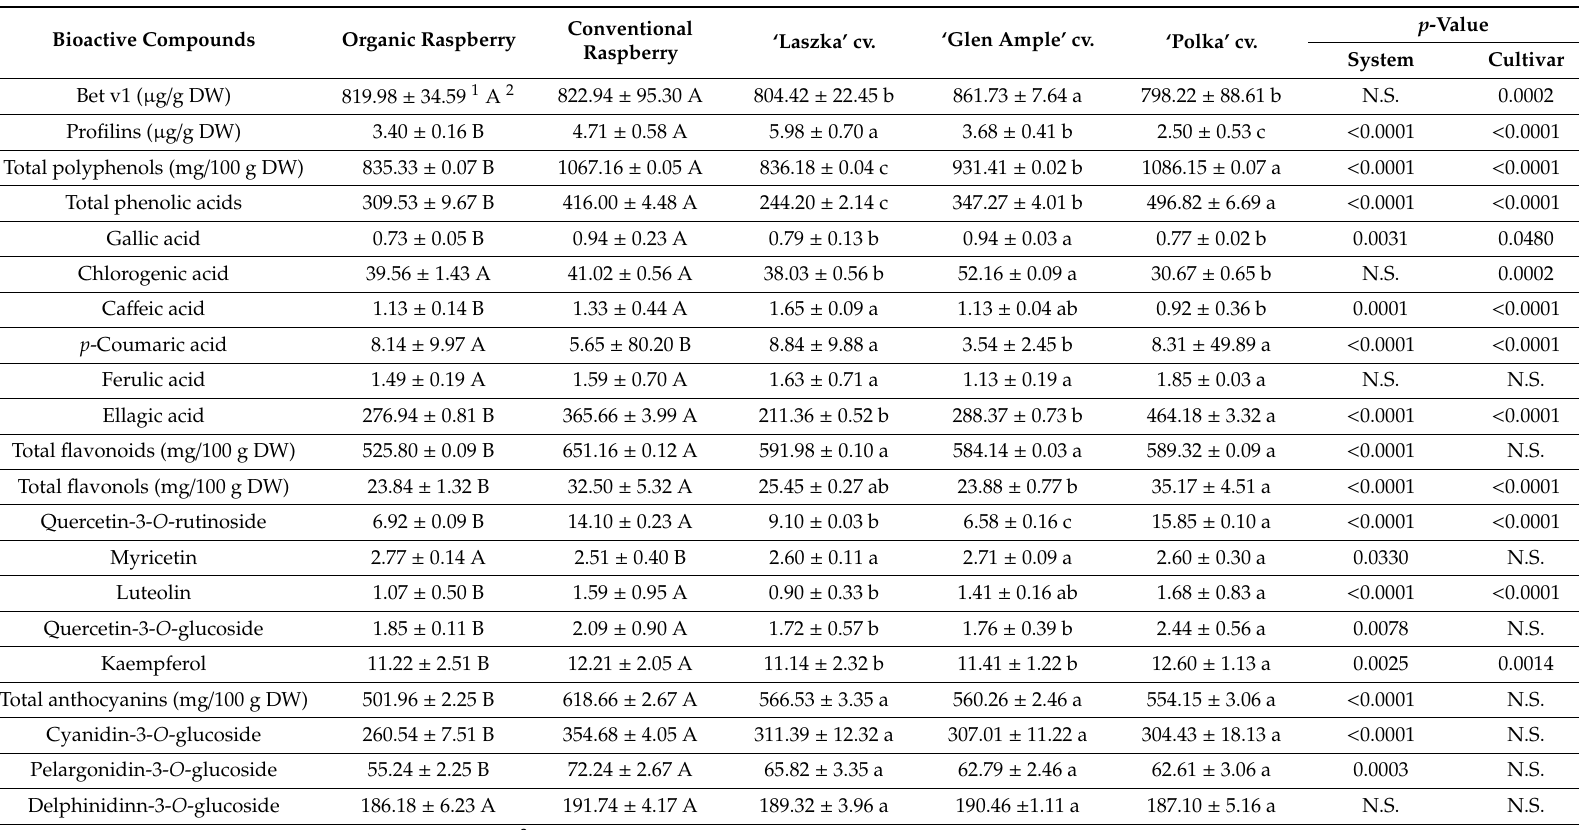
Table 3. The content of allergenic analogs and polyphenols in examined raspberry cultivars from organic and conventional farming system in